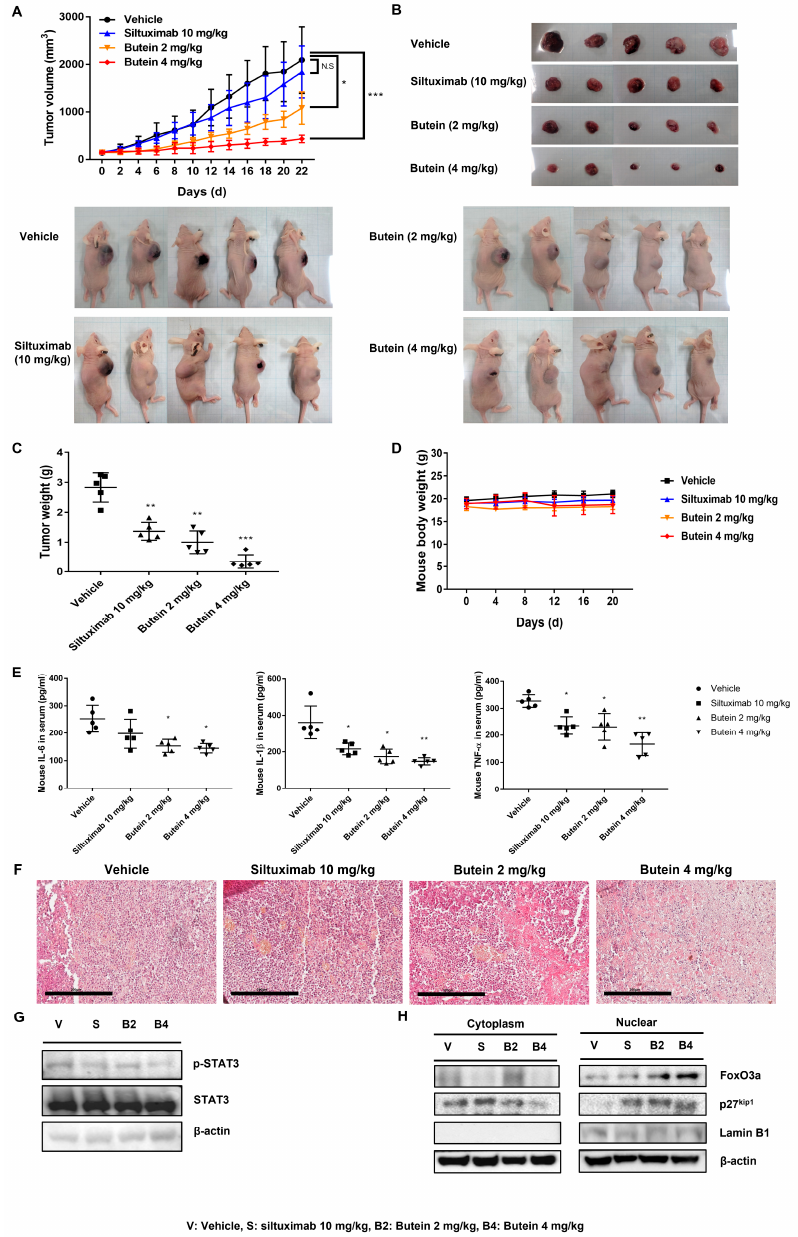
Figure 7. Butein inhibited A2780 and tumor growth in vivo. A2780 cells (1 × 10 7 ) were injected subcutaneously into BALB/c nude mice with an equal volume of PBS. When tumors reached a volume of 150 mm 3 , siltuximab (10 mg/kg) or butein (2 or 4 mg/kg) in a vehicle of 0.05% CMC and 5% DMSO was administered by intraperitoneal injection five times a week. ( A ) Tumor volumes were calculated from caliper measurements (* p < 0.05, *** p < 0.001). ( B ) The tumor masses were excised for comparison between the groups. ( C ) After 21 days of treatment, all mice were sacrificed, and the total mass of each tumor was determined at autopsy (n = 5 mice per treatment group) (** p < 0.01, *** p < 0.001). ( D ) The mouse body weight measured on the days indicated. ( E ) To assess IL-6, IL-1 β , and TNF- α production in serum in mouse blood, the total amount of IL-6, IL-1 β , and TNF- α were normalized to the vehicle (* p < 0.05, ** p < 0.01). ( F ) H&E staining results show the anticancer effect of butein on ovarian cancer. ( G ) The phosphorylation levels of STAT3 were determined using Western blotting of the harvested tumor tissue. β -actin served as a loading control. ( H ) The upregulated levels of FoxO3a and p27 kip1 were determined using Western blotting of nuclear extracts of the harvested tumor tissue. β -actin and Lamin B1 served as loading